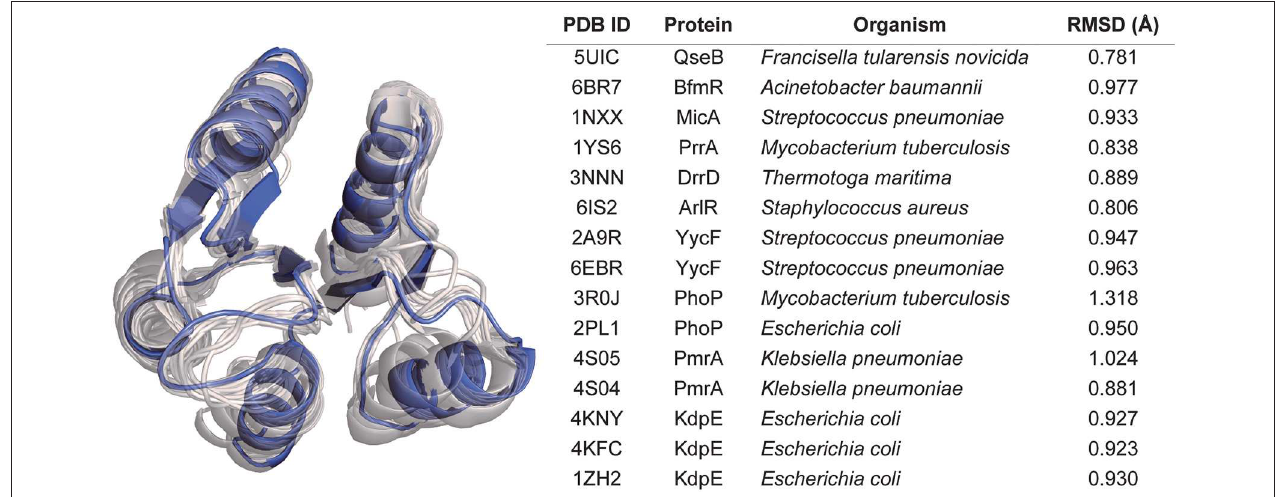
FIGURE 3 | Structural comparison of BfpR and other response regulators. Alignment of our BfpR structure to 15 other response regulators in the Protein Data Bank (PDB) demonstrates the high level of structural similarity between the BfpR and other OmpR/PhoP response regulator receiver domains. BfpR is shown in blue (left) with other response regulators in gray. The table (right) denotes the PDB ID for each structure used along with the C α RMSD. RMSD values were calculated from the alignment of each PDB entry to BfpR in